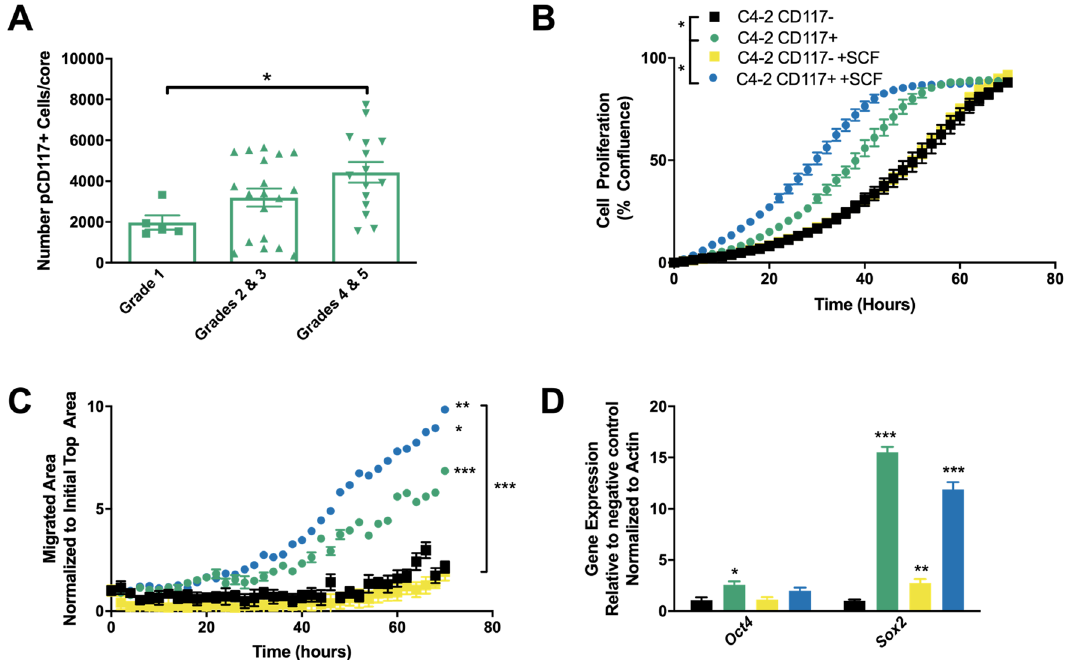
Figure 5. CD117 activation by SCF stimulates aggressiveness. ( A ) Tumor microarrays from prostate cancer patients were stained for phosphorylated (p) CD117. The number of positive cells per core were counted as mean ± SEM ( n = 5–20) and separated by Gleason score. ( B – D ) Sorted C4-2 cells were treated with 50 ng/mL stem cell factor (SCF) to activate CD117. ( B ) Proliferation was assessed by live-cell imaging and represented as mean percentage confluence ± SEM ( n = 12). ( C ) Chemotaxis through pores towards SCF was measured by live-cell imaging and represented as mean number of cells migrated to the initial numbers seeded ± SEM ( n = 8). ( D ) Gene expression of Oct4 and Sox2 were measured after SCF treatment and represented as mean fold change ± SEM ( n = 4). *Represents p < 0.05, **represents p < 0.01, and ***represents p < 0.005 by one-way